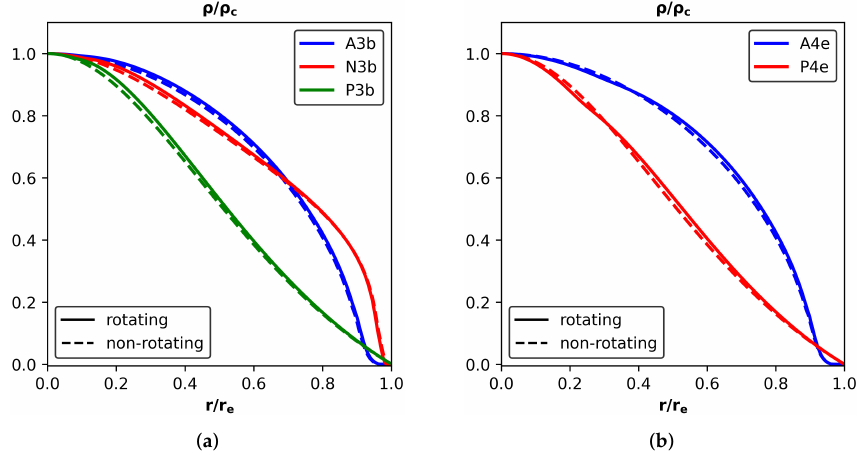
Figure 2. Rest mass density vs. radius on the equatorial plane for ( a ) models 4b and ( b ) models 4e in Table 1. Solid (dashed) lines are for the rotating (non-rotating) star. Values of the rest mass density are relative to the central value, while values of the radius are relative to the equatorial radius of the star. See the text for more details.